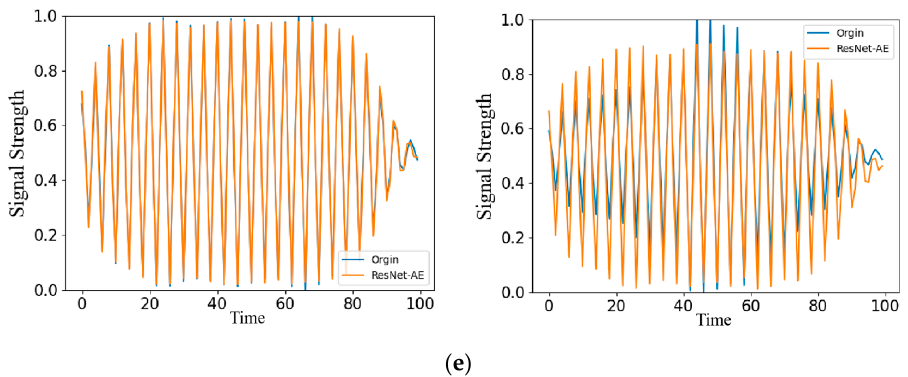
Figure 9. Reconstruction signal of common anomaly detection models: ( a ) Abnormal detection results of AE; ( b ) Abnormal detection results of VAE; ( c ) Abnormal detection results of CNN-AE; ( d ) Abnormal detection results of LSTM-AE; ( e ) Abnormal detection results of ResNet-AE.